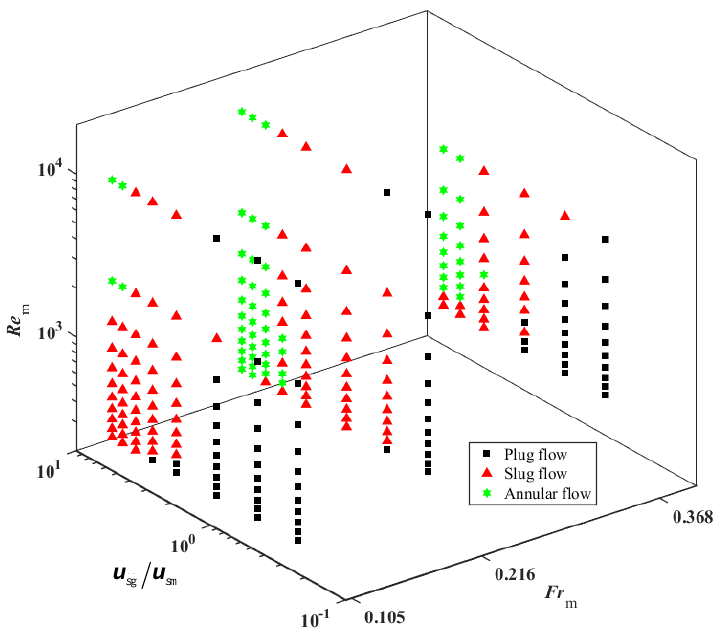
Figure 8. Flow pattern maps in the horizontal section, in which the dimensionless number Re m ranged from 298 to 21,193, the dimensionless number u sg /u sm ranged from 0.25 to 6, and the dimensionless number Fr m was fixed at 0.105, 0.216, and 0.368.